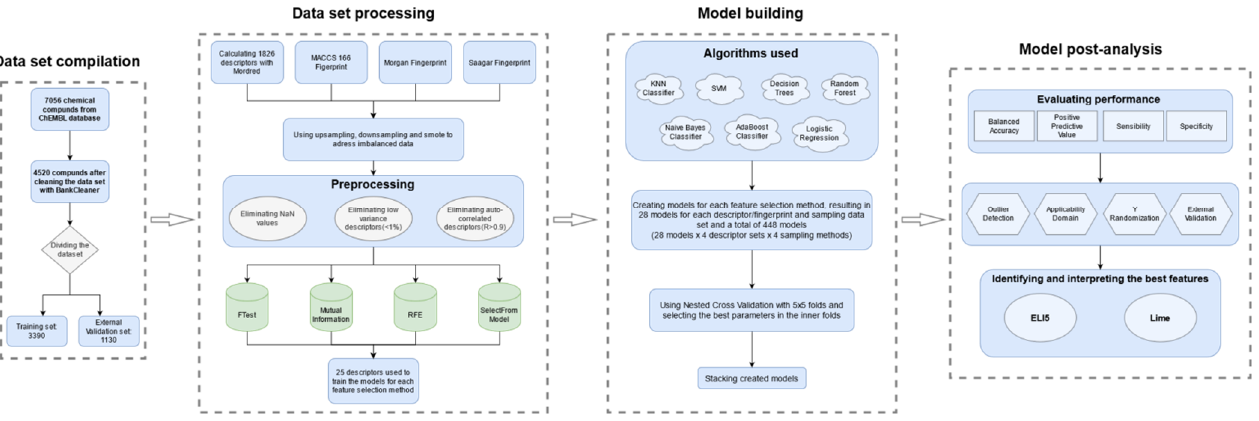
Figure 4. Graphical workflow of the modeling process used in this study.